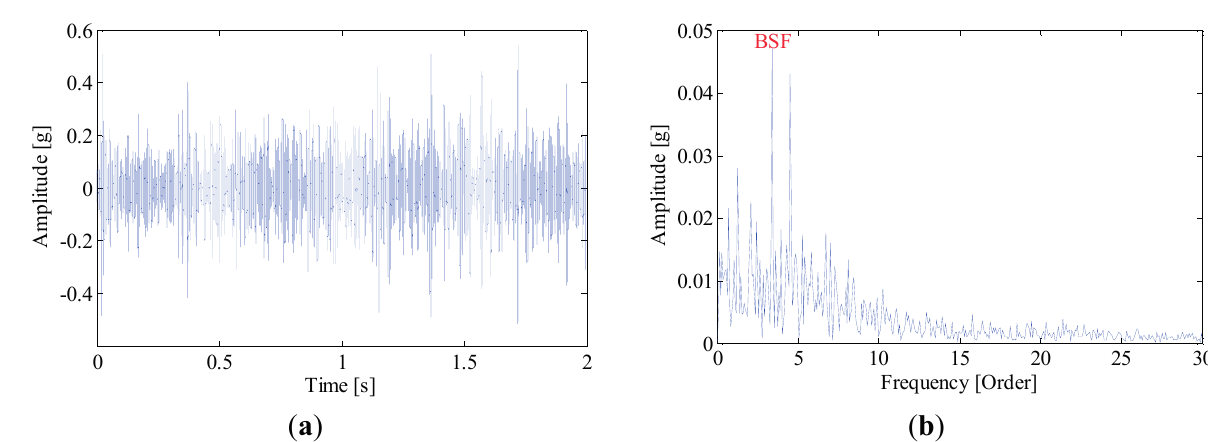
Figure 30. ( a ) Waveform and ( b ) envelope order spectrum of IMF6.